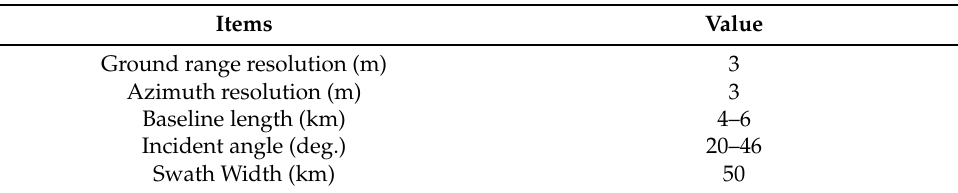
Table 3. Parameters of the interferometry